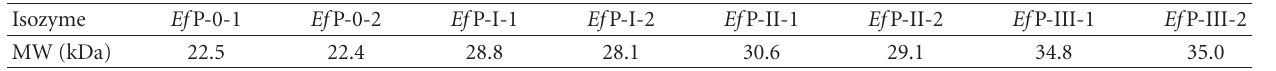
Table 1: The molecule mass of the eight